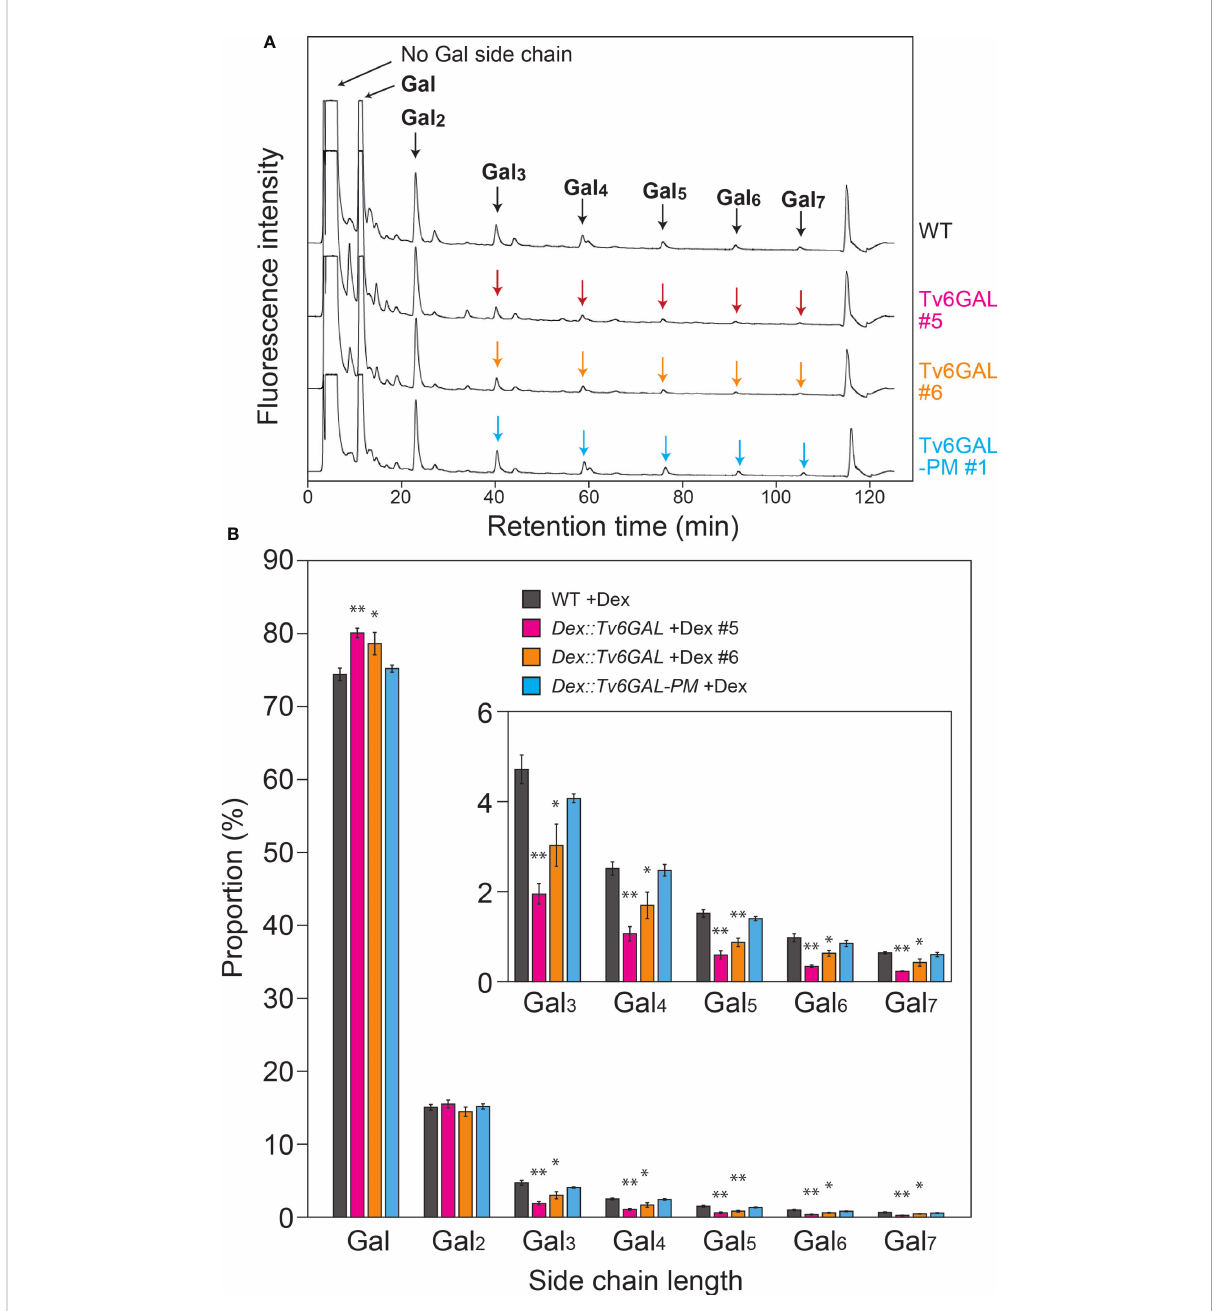
FIGURE 4 In vivo structural modi fi cation of type II AGs. (A) Representative chromatogram of b -1,6-galactooligosaccharides. Type II AGs were extracted from WT, Dex::Tv6GAL #5 and #6, and Dex::Tv6GAL-PM #1 plants grown in the presence of Dex and subjected to structural analysis as performed for in vitro modi fi cation to obtain the distribution of chain lengths of b -1,6-galactooligosaccharides (Supplementary Figure S2). In this chromatogram, b -1,6-galactooligosaccharides larger than b -1,6-Gal 2 were examined. (B) Distribution of Gal lengths of b -1,6-galactan side chains. The distribution of b -1,6-galactan side chains was calculated based on the peak areas of b -1,6-galactooligosaccharides. Data are mean values with ± SD (n=3 biological replicates). Asterisks indicate signi fi cant differences from WT plants (Student ’ s t -test, *, P <0.05; **, P